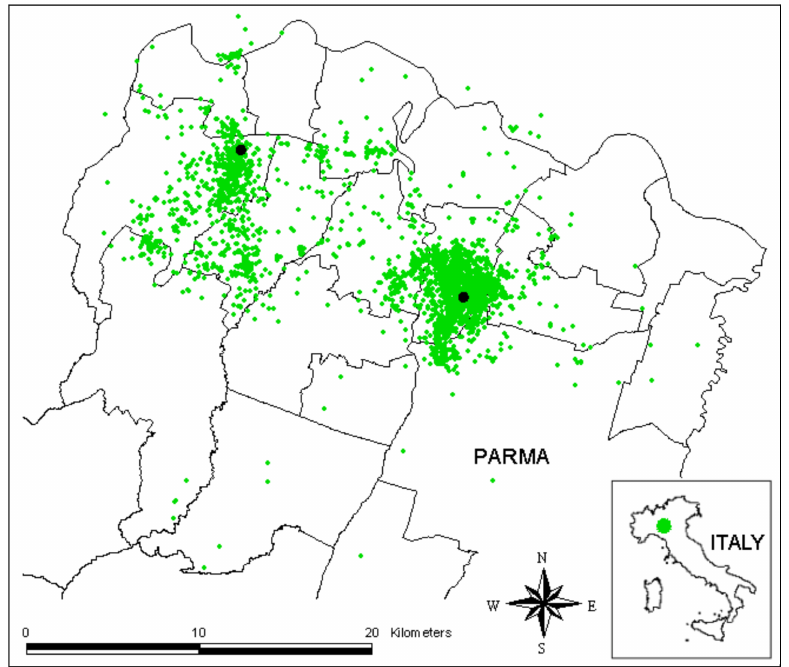
Figure 1. Study area (the province of Parma, Italy). Municipalities and 5840 GPS points (green dots) of the tracked red-footed falcons are shown. Black dots indicate the two red-footed falcon colonies (Colony A on the left, and Colony B on the